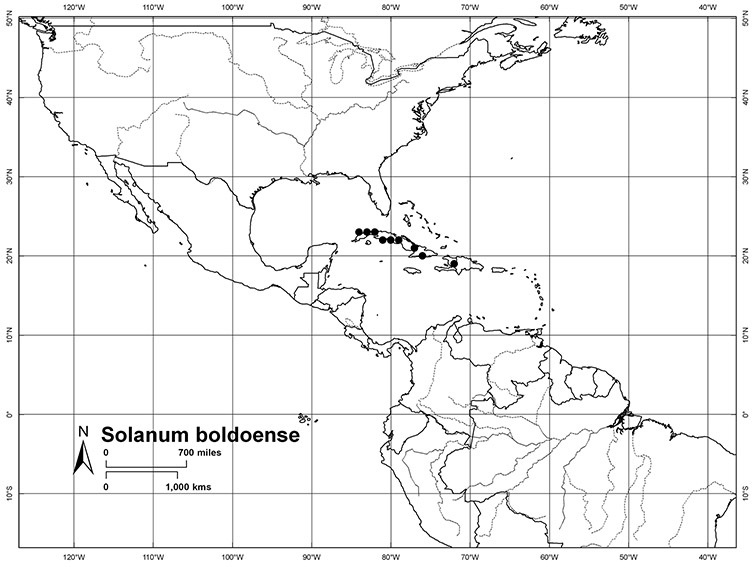
Distribution of Solanum boldoense Dunal & A.DC.